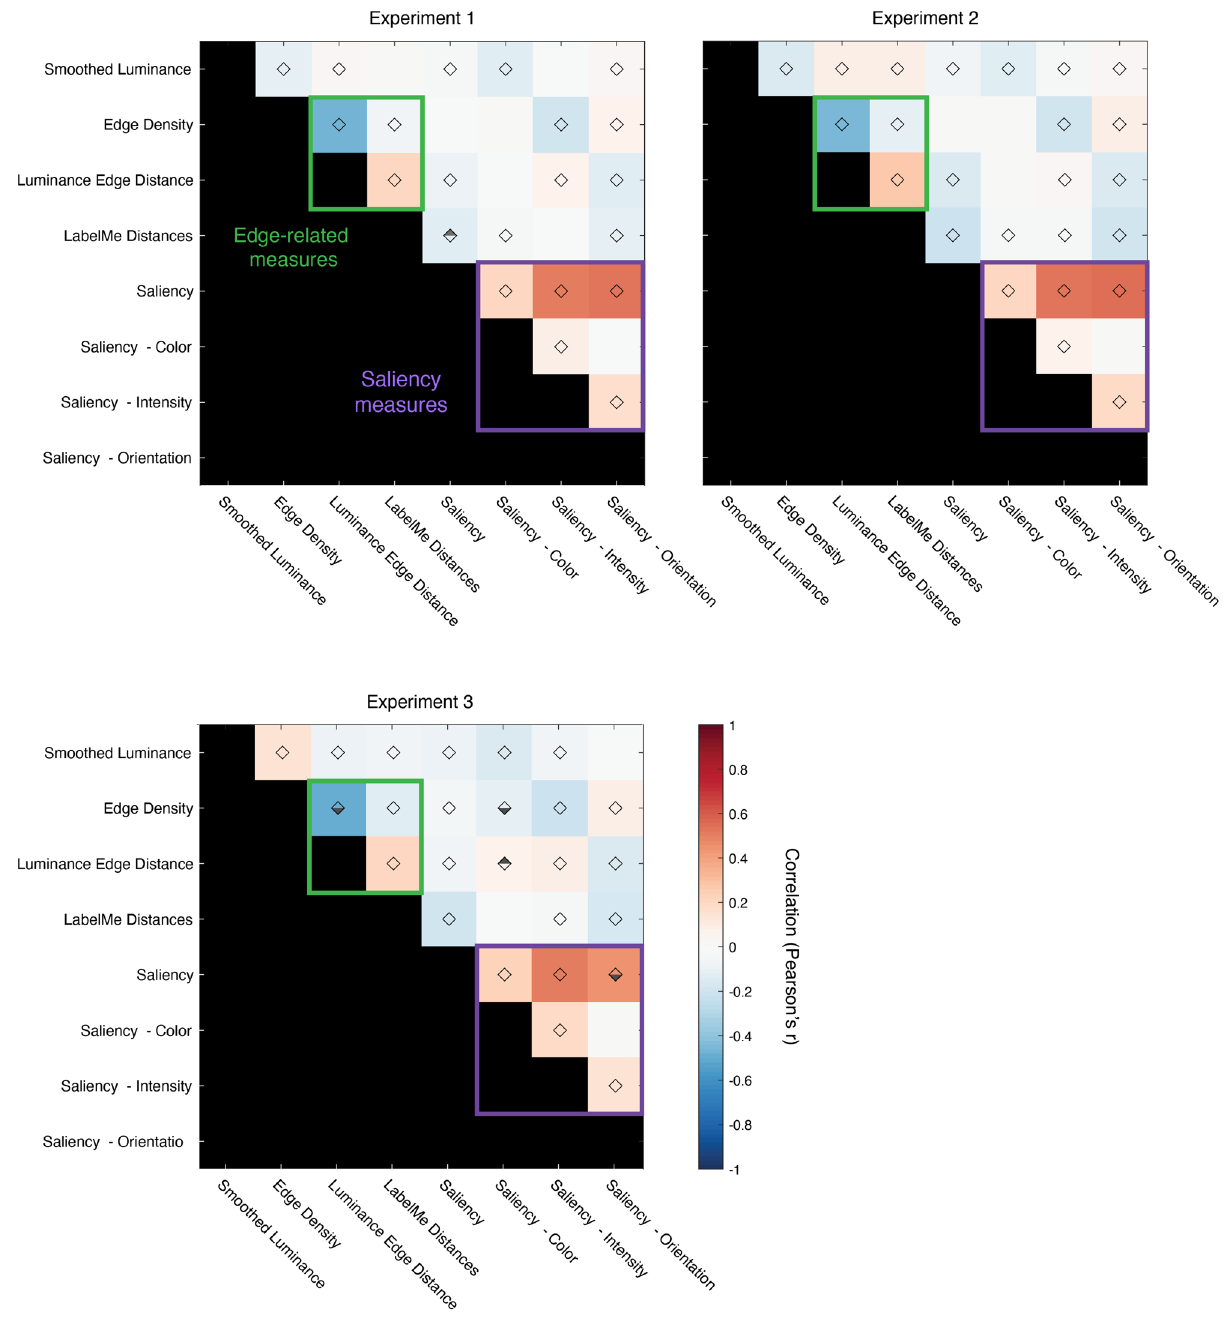
Figure 4. Correlation between image difference scores. Correlation values were calculated across all pairs of difference scores from all analyzed trials in each experiment (N = 6760, N = 8403, and N = 8239 in Experiments 1, 2, and 3, respectively). Diamond symbols indicate statistically significant correlations after controlling for a false discovery rate of 0.05 using the Benjamini–Hochberg procedure. Half-filled diamond symbols indicate correlations that are significantly above (upper-half filled) or below (lower-half filled) those in the permuted null to the images shown. We note that the correlations in the null distribution generally preserve the relationship between image features; in other words, features that were highly correlated within these images (e.g., correla- tions within the saliency channels) are also well-correlated in the null distribution. However, as shown in Fig. 4, we identified a small subset of correlation values (one pair of features in Experiment 1 and four in Experiment 3) where the observed correlation was significantly different from the null. Second, if the correlations between pairs of difference scores derived from different measures (Fig. 4) are largely responsible for the effects we see in Fig. 2, we would expect this to emerge at the individual observer level